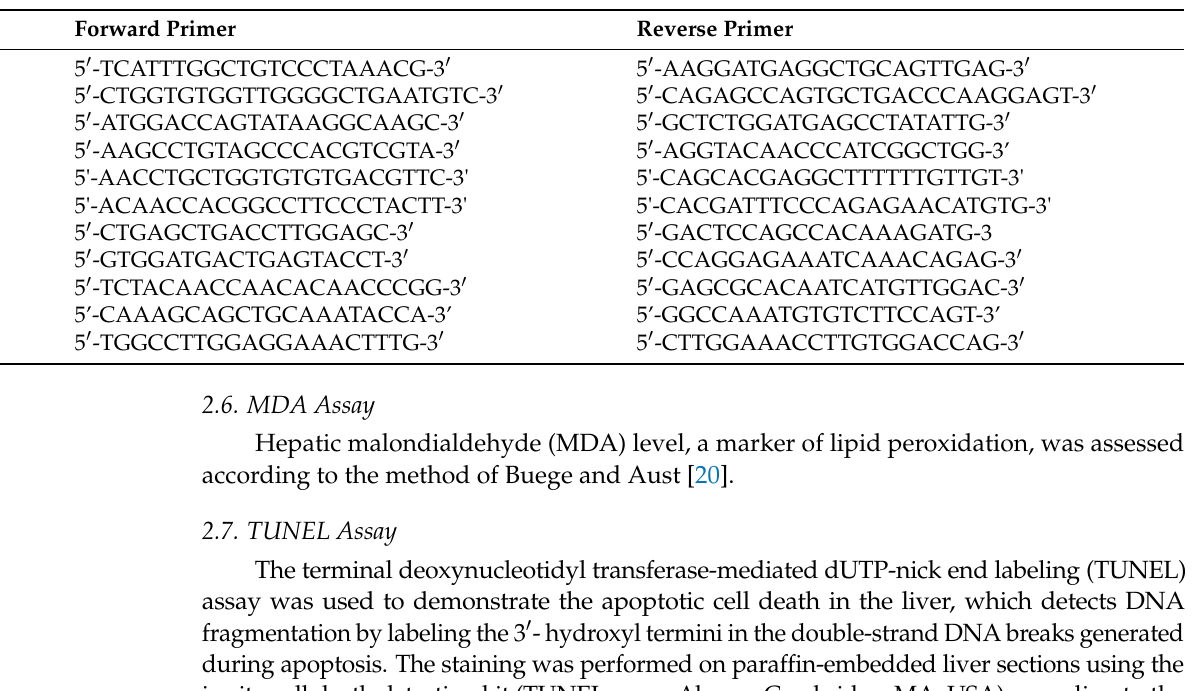
Table 1. Primers’ sequences used for